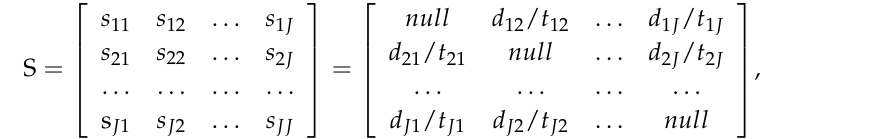
Figure 5. The experimental setup.